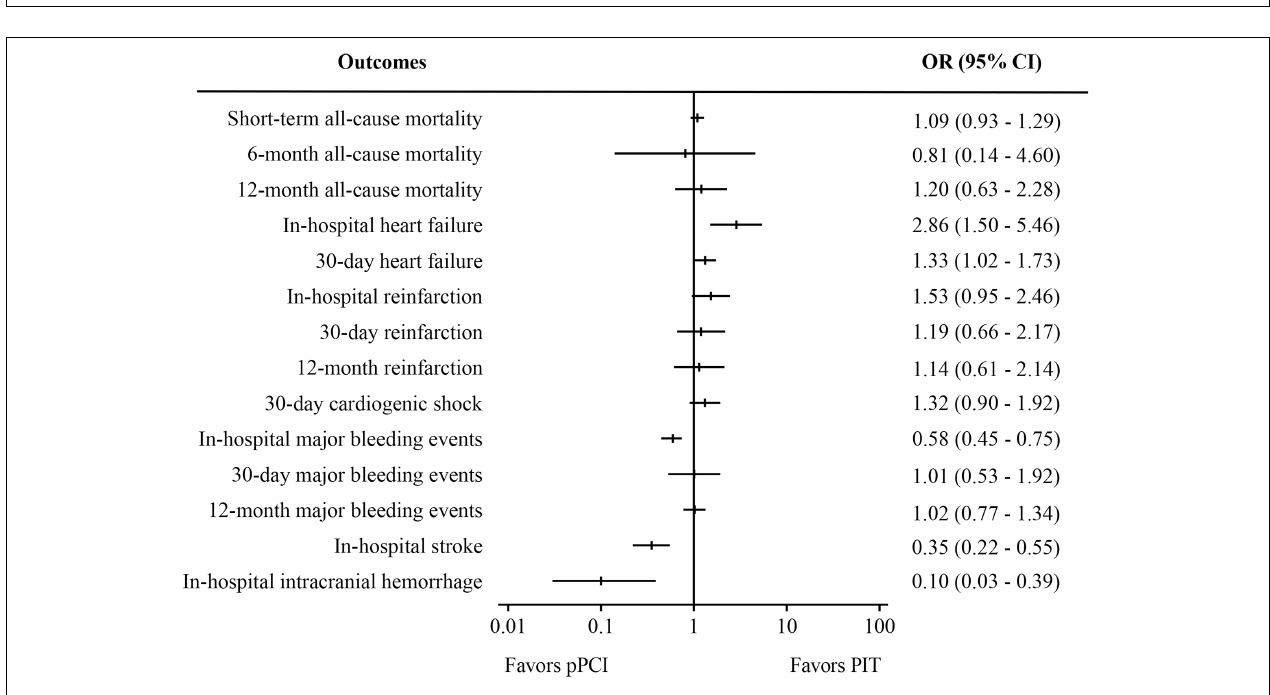
FIGURE 3 | Meta-analysis results of observational studies. PIT, pharmaco-invasive therapy; pPCI, primary percutaneous coronary intervention.